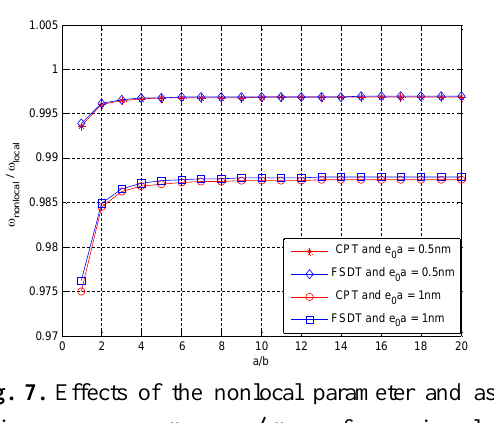
Fig. 6. Agglomeration effects on / piezoelectric nanocomposite plate a- CPT b- FSDT